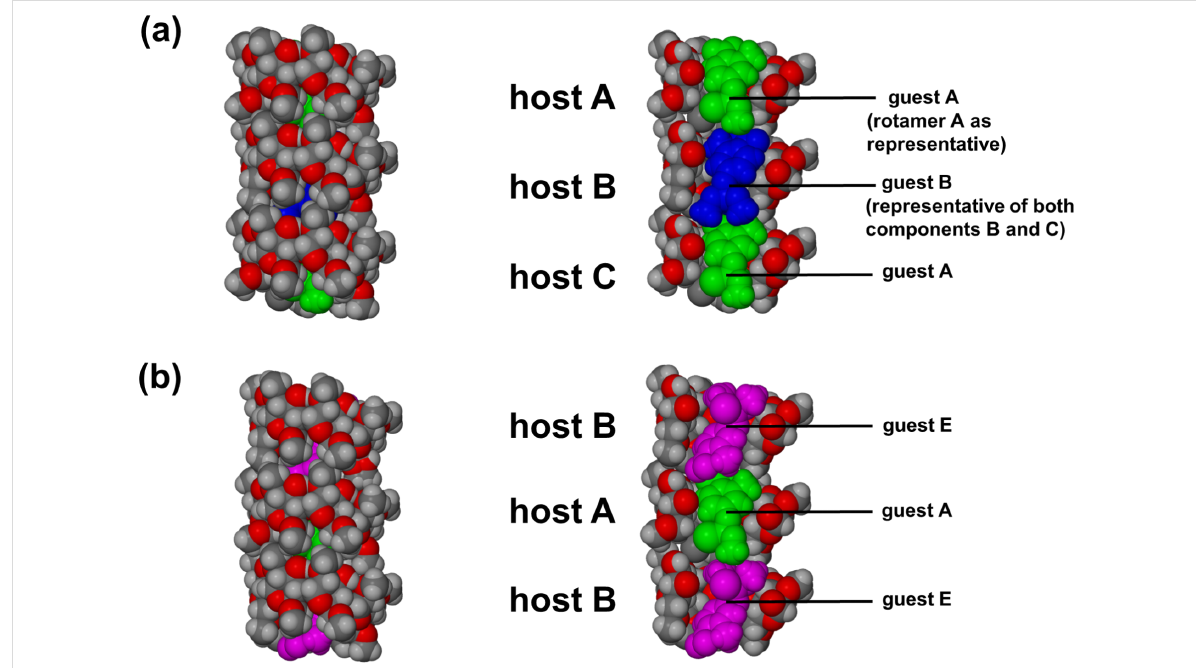
Figure 7: Space-filling diagrams showing the relative orientations of guest molecules within the cavities of the independent DIMEB molecules. Side- views of the complexes and cross-sectional views showing guest molecules (a) A and B, and (b) guest molecules A and E, encapsulated by their respective host molecules.